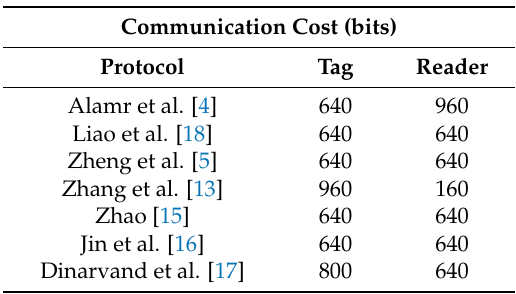
Table 2. Cost of communications between tag and reader.